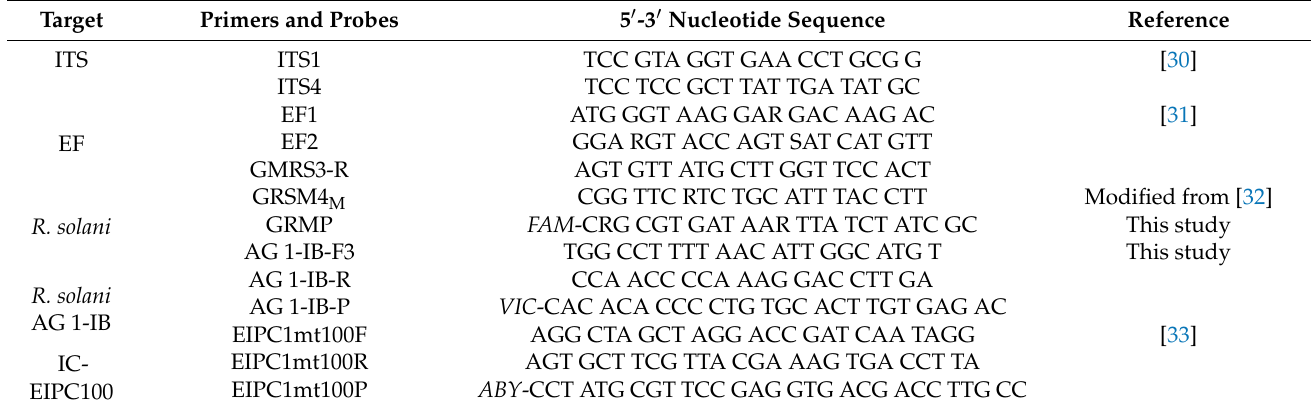
Table 2. Primers and probes used in this